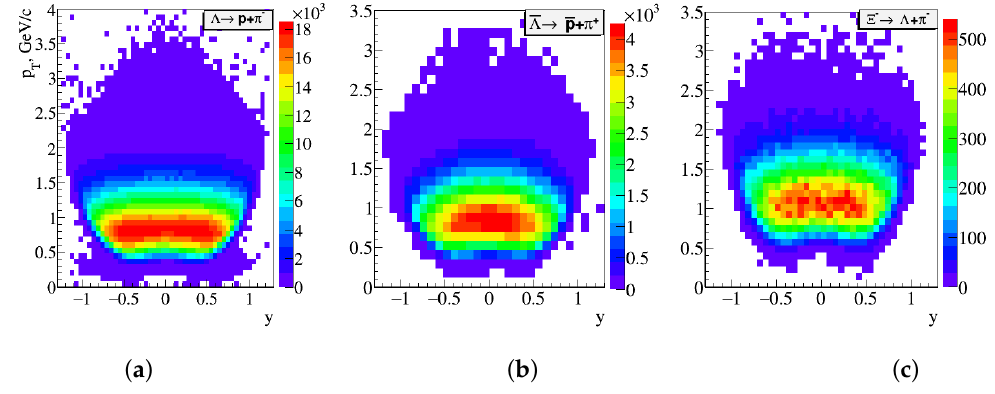
Figure 4. Transverse momentum p T vs rapidity y phase space of reconstructed true hyperons: ( a ) Λ , ( b ) ¯ Λ , ( c ) Ξ − .